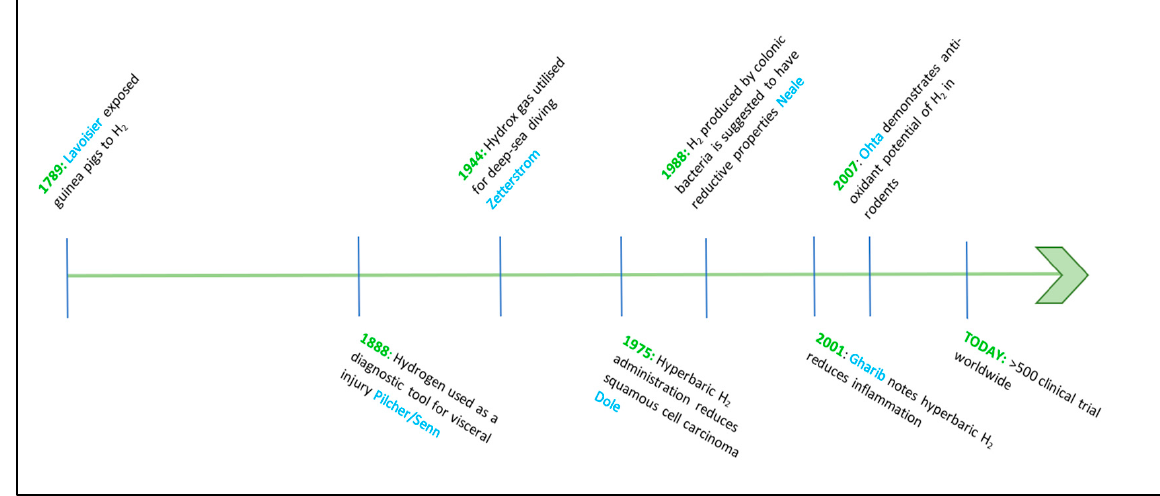
Figure 1. Timeline of hydrogen gas used as a medical intervention. Legend: from left to right. Dates, usage, and researchers who utilized H 2 for medical purposes.